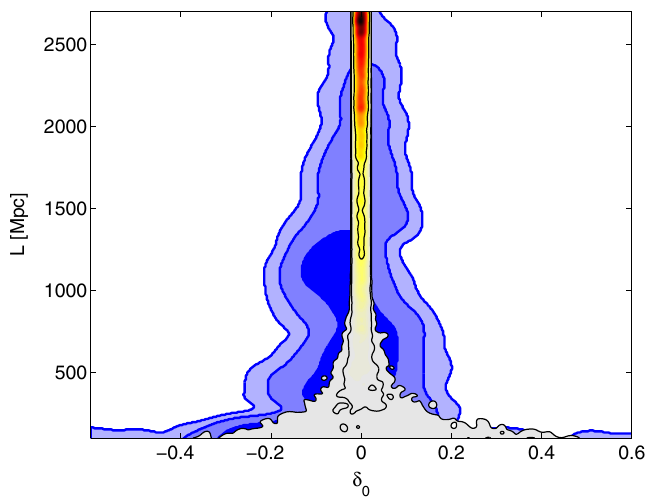
Fig. 58 Marginalized constraints on the amount of radial inhomogeneity δ 0 at a given scale L from local Hubble parameter measurements, supernova Ia data, CMB anisotropies, BAO observations, Compton y- distortion and kSZ constraints and age data (as lower bounds only) at 68, 95 and 99% confidence level (blue contours), compared to the expected level of inhomogeneity within a Λ CDM model that satisfies the Copernican principle (red-to-gray contours). Image reproduced with permission from Valkenburg et al. (2013b), copyright by the